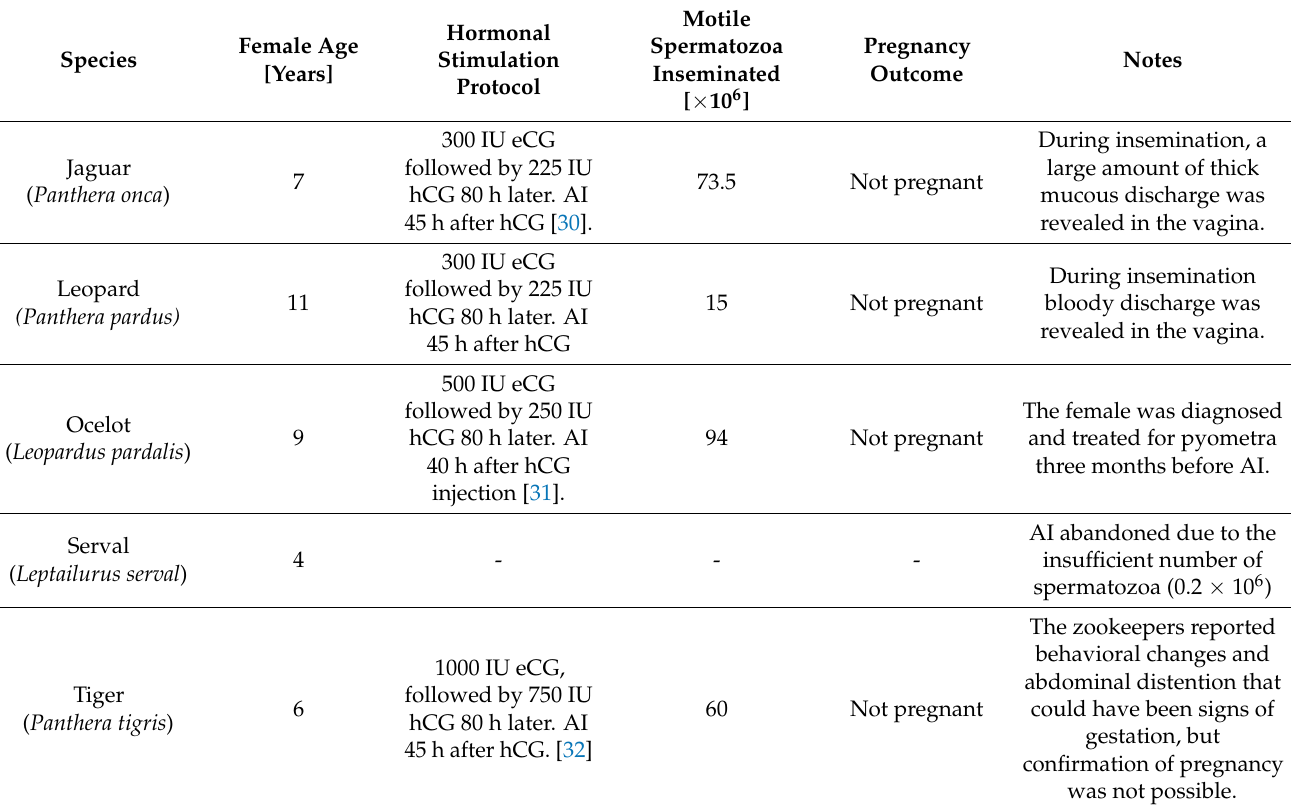
Table 2. Artificial inseminations (AI) in wild felids. In all cases, fresh spermatozoa (collected within one hour before procedure) were deposited in the uterus by transcervical intrauterine endoscopic